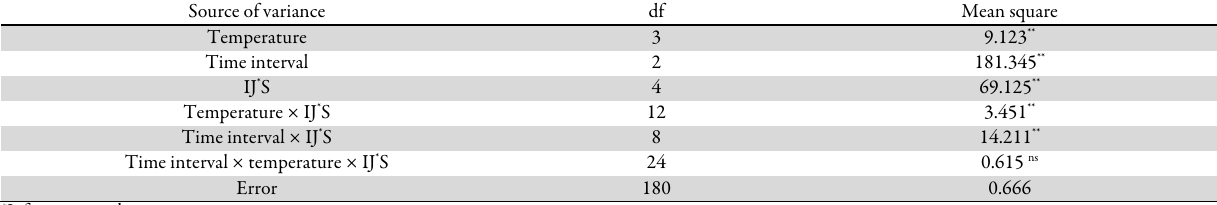
Table 1. Analysis of variance of the effect of Steinernema feltiae on adult of Bruchus lentis